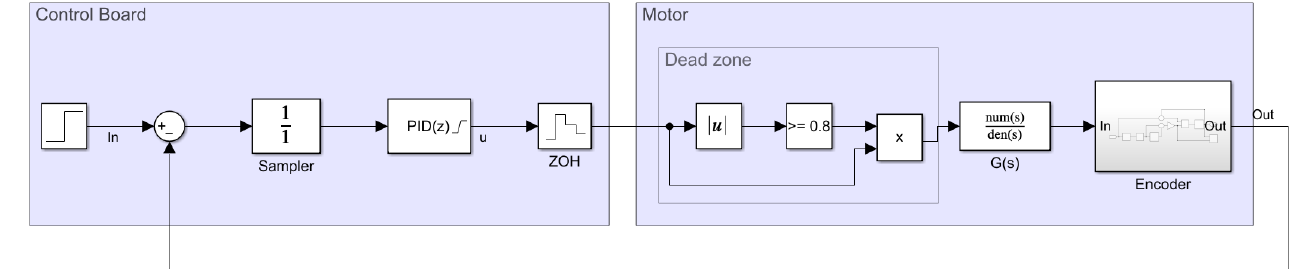
Figure 16. Simulink ® continuous control loop model used by the FRB PID tuner.